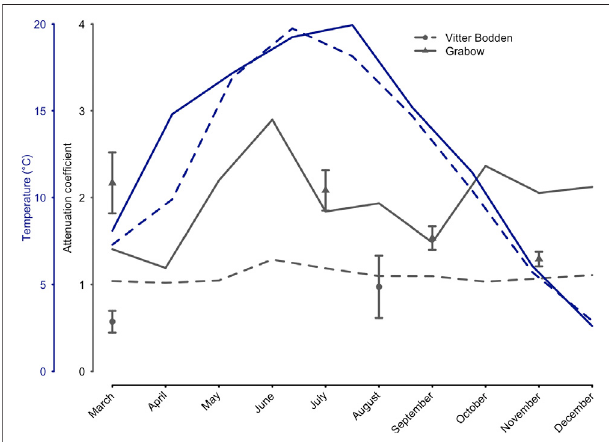
FIGURE 2 | Attenuation coefficient and water temperature in 2017. Temperature ( ° C), salinity, Chlorophyll a (µg L − 1 ) and seston (mg L − 1 ) were monitored biweekly (Vitter Bodden – VB) and monthly (Grabow – GB). Blue dashed (VB),and solidlines (GB)show thetemperaturedevelopmentfor both sampling locations (March to September). The attenuation coef fi cient (m − 1 ) was calculated based on Chlorophyll, seston, and salinity (Xu et al., 2005), and additionally measured with Li-Cor sensors simultaneously to macrophyte sampling. Circles (VB) and triangles (GW) show the measured attenuation coef fi cients during the sampling occasions (mean values + standard deviations).